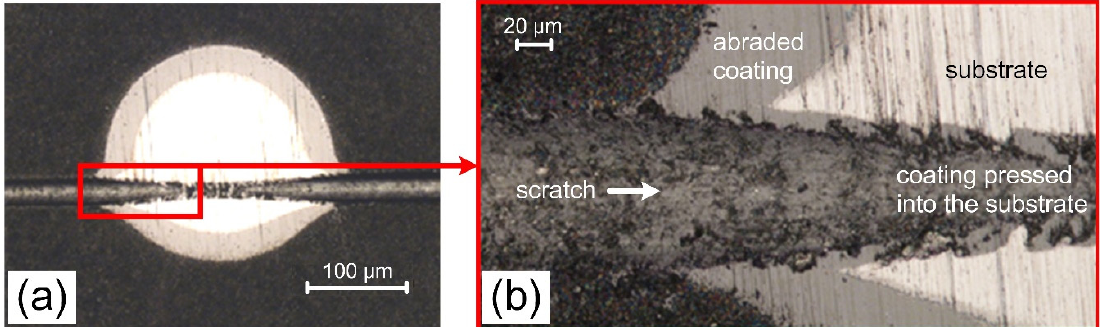
Figure 9. Optical microscope micrographs of the result of the combined test (scratch test and spherical abrasion test) for AlCrN coating deposited at pN2 = 0.8 Pa and Ic = 80 A ( a ), and ( b ) the enlarged image of the red rectangle in Figure 9a. Image of the coating from the top.